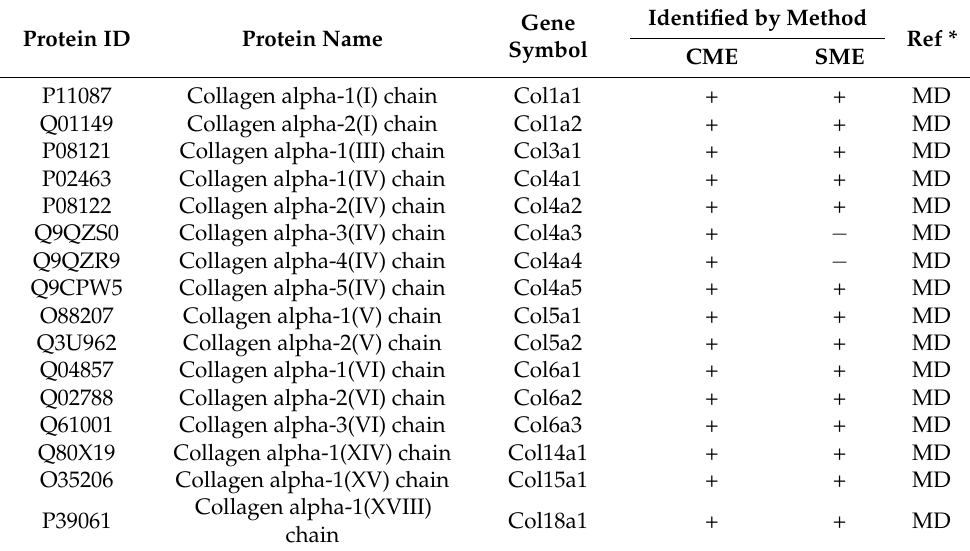
Table A1. The list of core matrisome proteins belonging to the category of collagens and identified in at least two of the biological replicates.